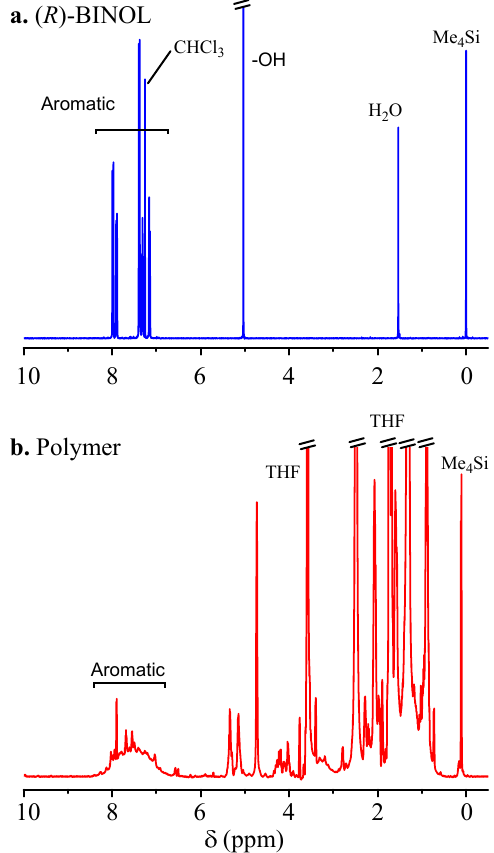
Figure 4. 1 H NMR spectra: ( a ) ( R )-BINOL taken in CDCl 3 ; ( b ) the polymeric product obtained from ( R )-BINOL in a CH 3 CN solution upon irradiation for 5 h ([( R )-BINOL] o = 1.0 × 10 − 3 M, cell path = 5 mm) taken in THF- d 8 [400 MHz, room temperature, Me 4 Si].